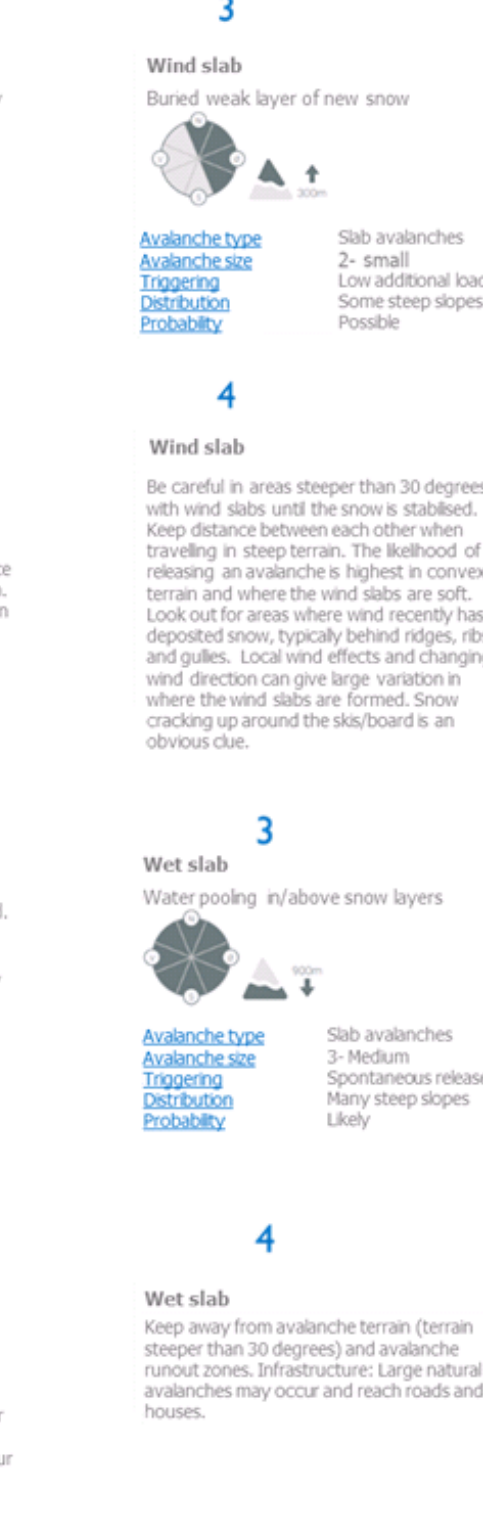
Figure 3. Alternatives 1 to 4 used for the two scenarios: (a) level 2 and wind slab (upper panel) and (b) level 4 and wet slabs (lower panel). The text has been translated from Norwegian into